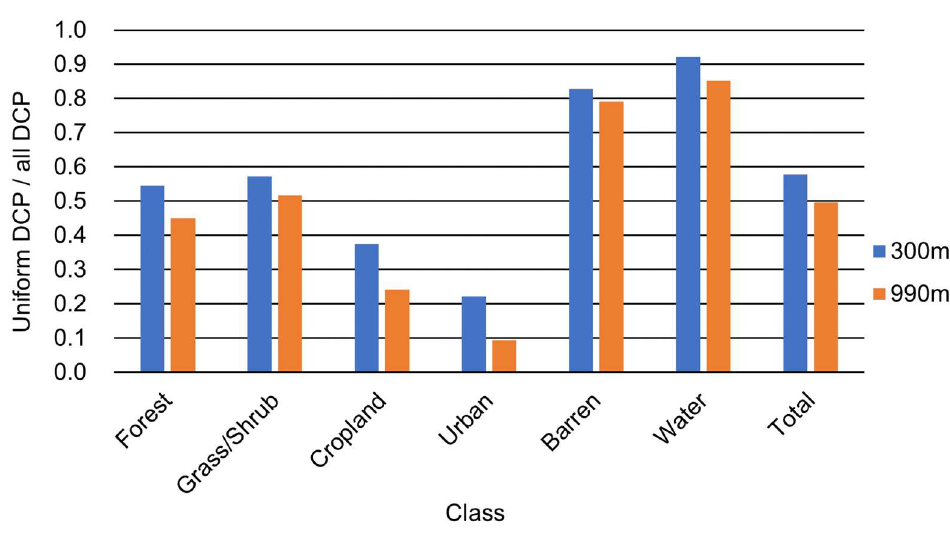
Figure 3. The proportion of DCP points with guaranteed spatial uniformity among all DCP points in